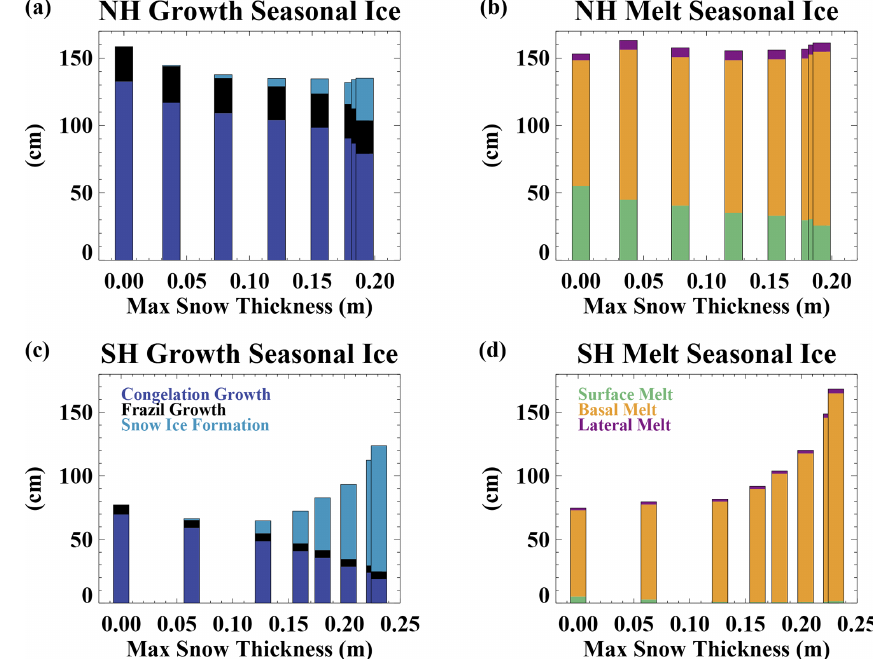
Figure 10. As in Fig. 9 but for the seasonal sea ice